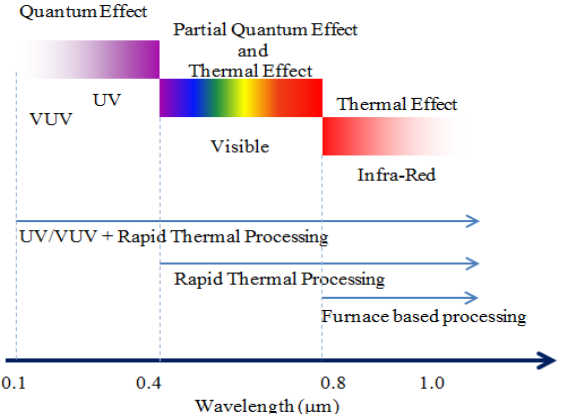
Figure 6. Radiation spectrum distribution for thermal processing techniques.